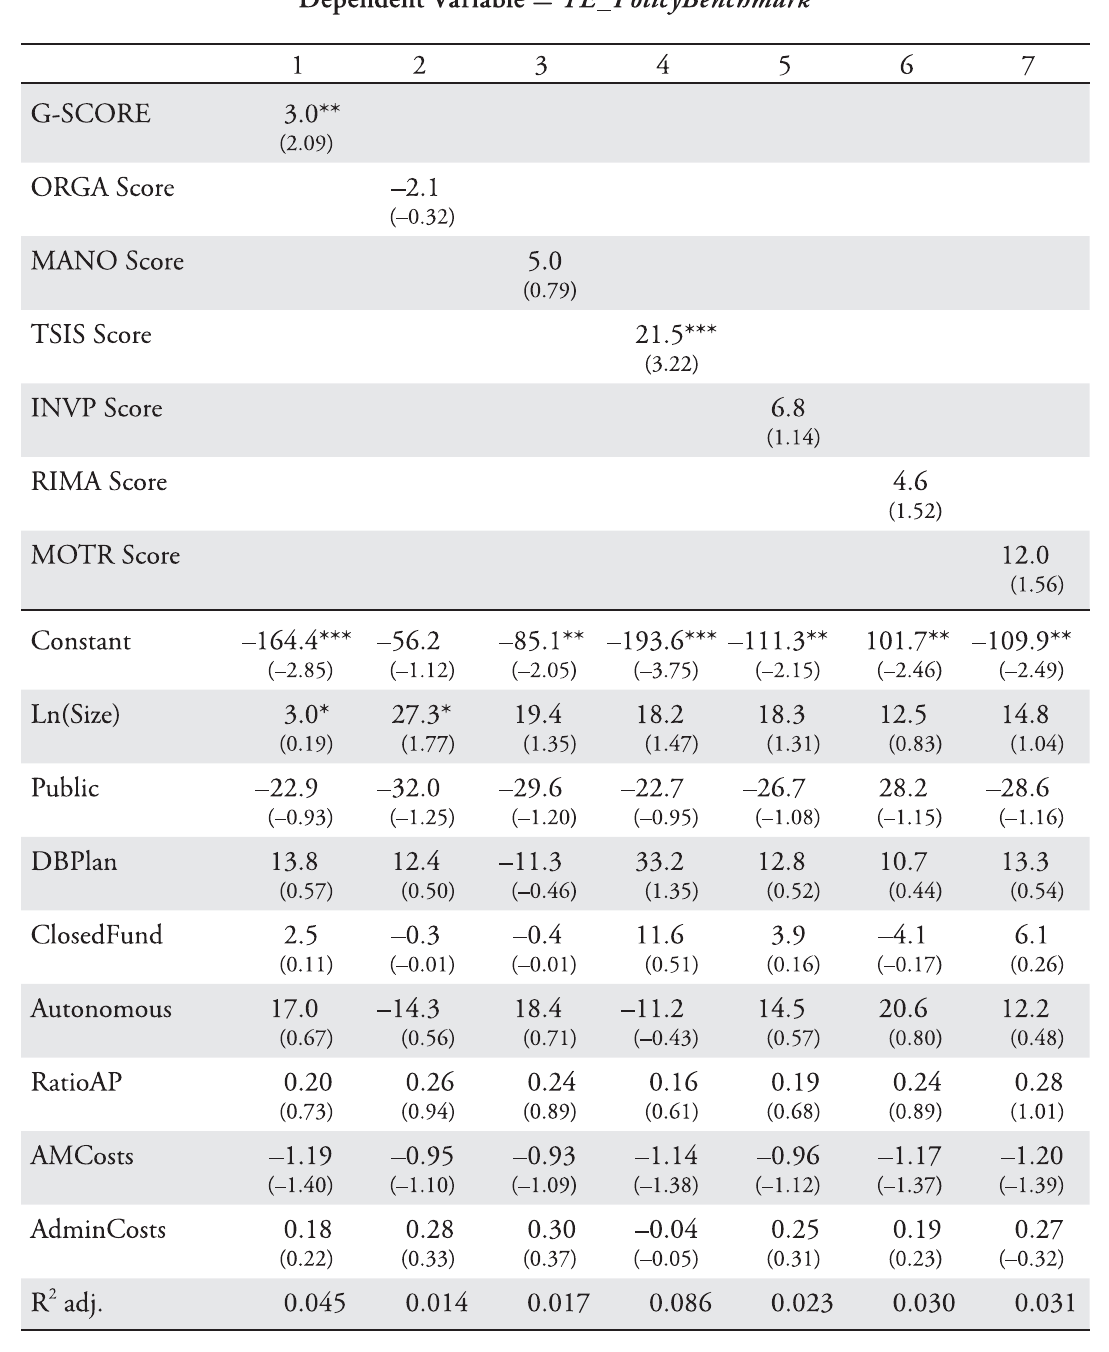
Table 15: Governance and Outperformance of the Policy